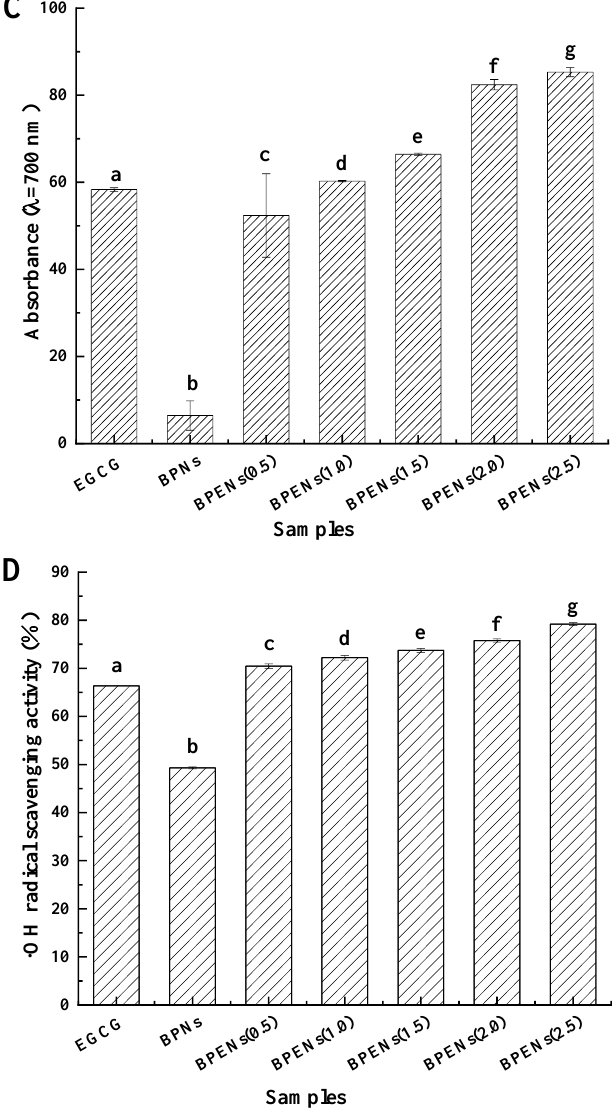
Figure 5. The in vitro antioxidant capacity of BPENs, as determined by the DPPH ( A ), ABTS ( B ), FRAP ( C ), and hydroxyl radical scavenging capacity ( D ), respectively. Histograms followed by different letters were significantly different at p < 0.05.